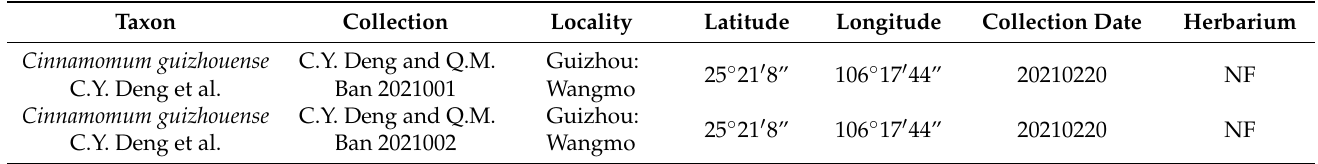
Table 1. Vouchers of species used in this study.